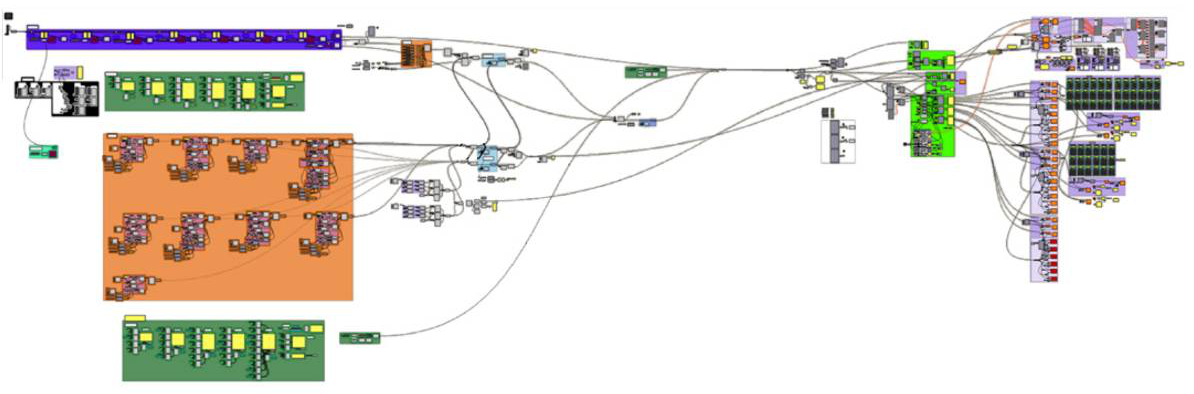
Figure 11. The simulation algorithm for indoor environmental analysis.